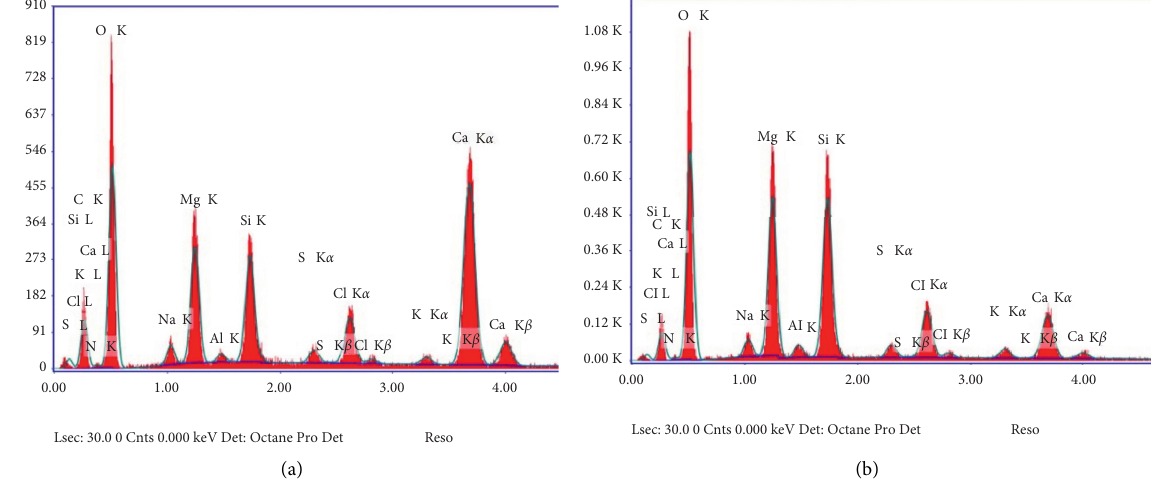
Figure 2: EDX spectra: (a) DPAC adsorbent and (b) PPAC Table 1: The main functional groups detected on the surfaces of DPAC and PPAC.